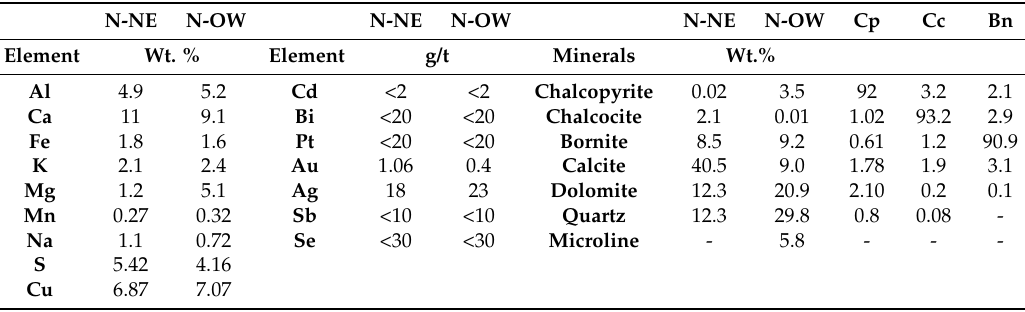
Table 1. Quantitative analysis of the ore sample using: XRF and XRD analysis.